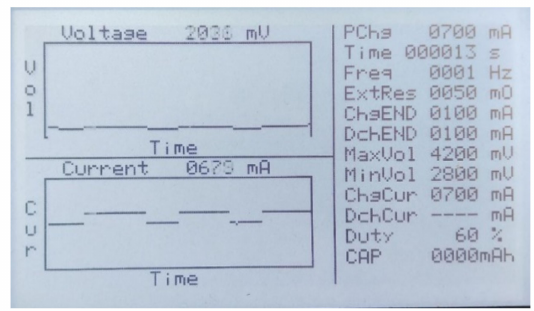
Figure A3. Interface of the MTC at initial pulse charging 60%, 700 mA, for a single cell test at arbitrary settings.